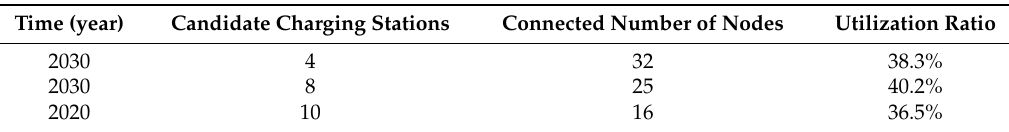
Table 12. Plan for the charging station.